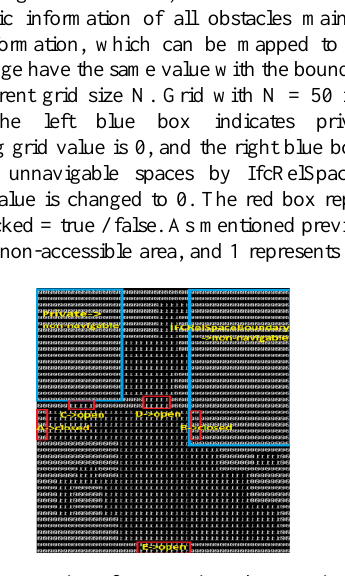
Figure 5. Mapping of geometric and semantic information